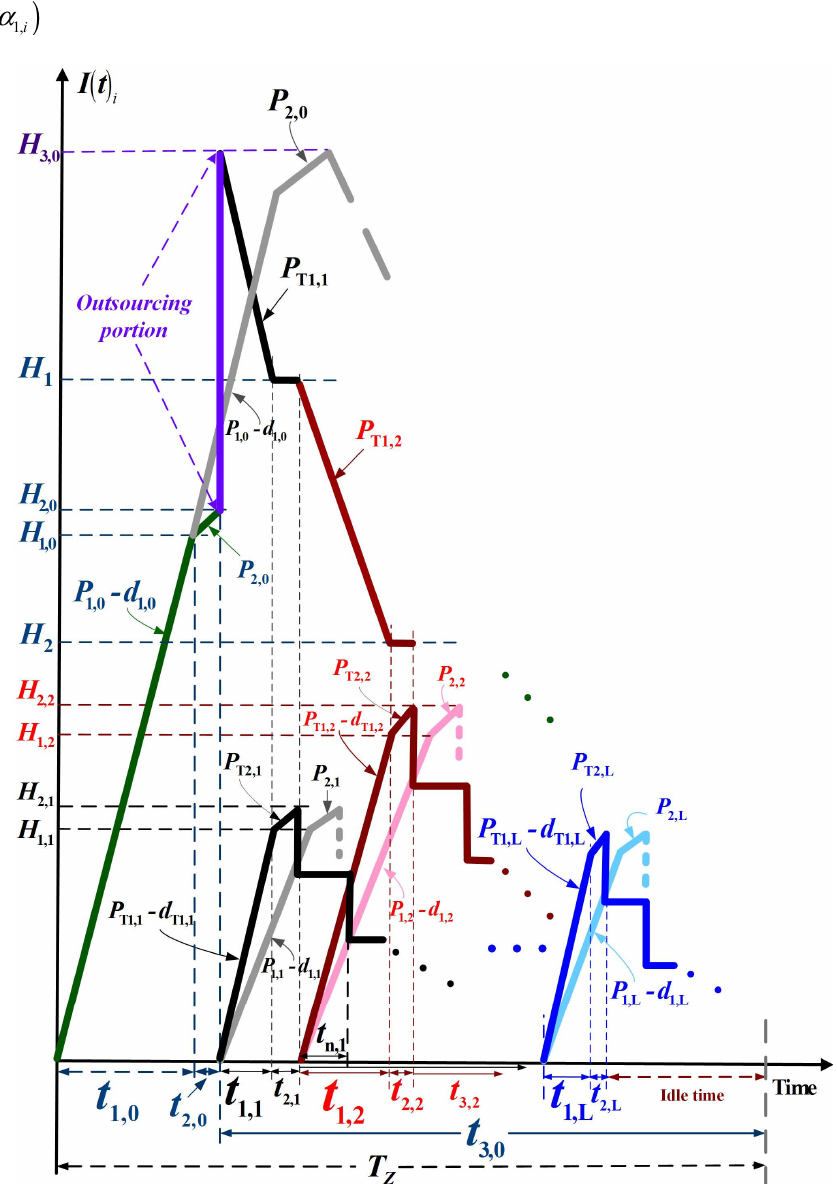
Fig. 1. The stock level in our model versus a problem without outsourcing nor overtime Poor quality with random faulty rates x 0 and x i happen in both fabricating stages; rework actions are used to fix all nonconforming items made entirely. Fig. 1 shows the stock level of standard part surges to H 1,0 when t 1,0 completes, and it reaches H 2,0 when t 2,0 completes. By receiving outsourcing parts, it further accumulates H 3,0 before stage 2 starts. In contrast, in stage 2, the stock level of end merchandise i surges to H 1, i when t 1, i ends, and it reaches H 2, i when t 2, i ends. Then, end merchandise i ’s inventories are distributed to the clients in equal-size multiple shipments (see Fig. 1). Fig. 2 exhibits the faulty stock level of our model. It illustrates that the faulty standard part’s inventory surges to ( d 1,0 t 1,0 ) when t 1,0 completes and gradually declines to zero when reworking t 2,0 ends. In stage 2, the faulty end merchandise i ’s inventory level has the same status. ( P 1,0 – d 1,0 ) > 0 and ( P T1, i – d T1, i – λ i ) > 0 must hold to avoid the stock-out situations in both stages. The goal of this particular multiproduct manufacturing-transportation integration model is to decide the optimal policy of fabricating cycle time and delivery frequency through minimizing the total operating